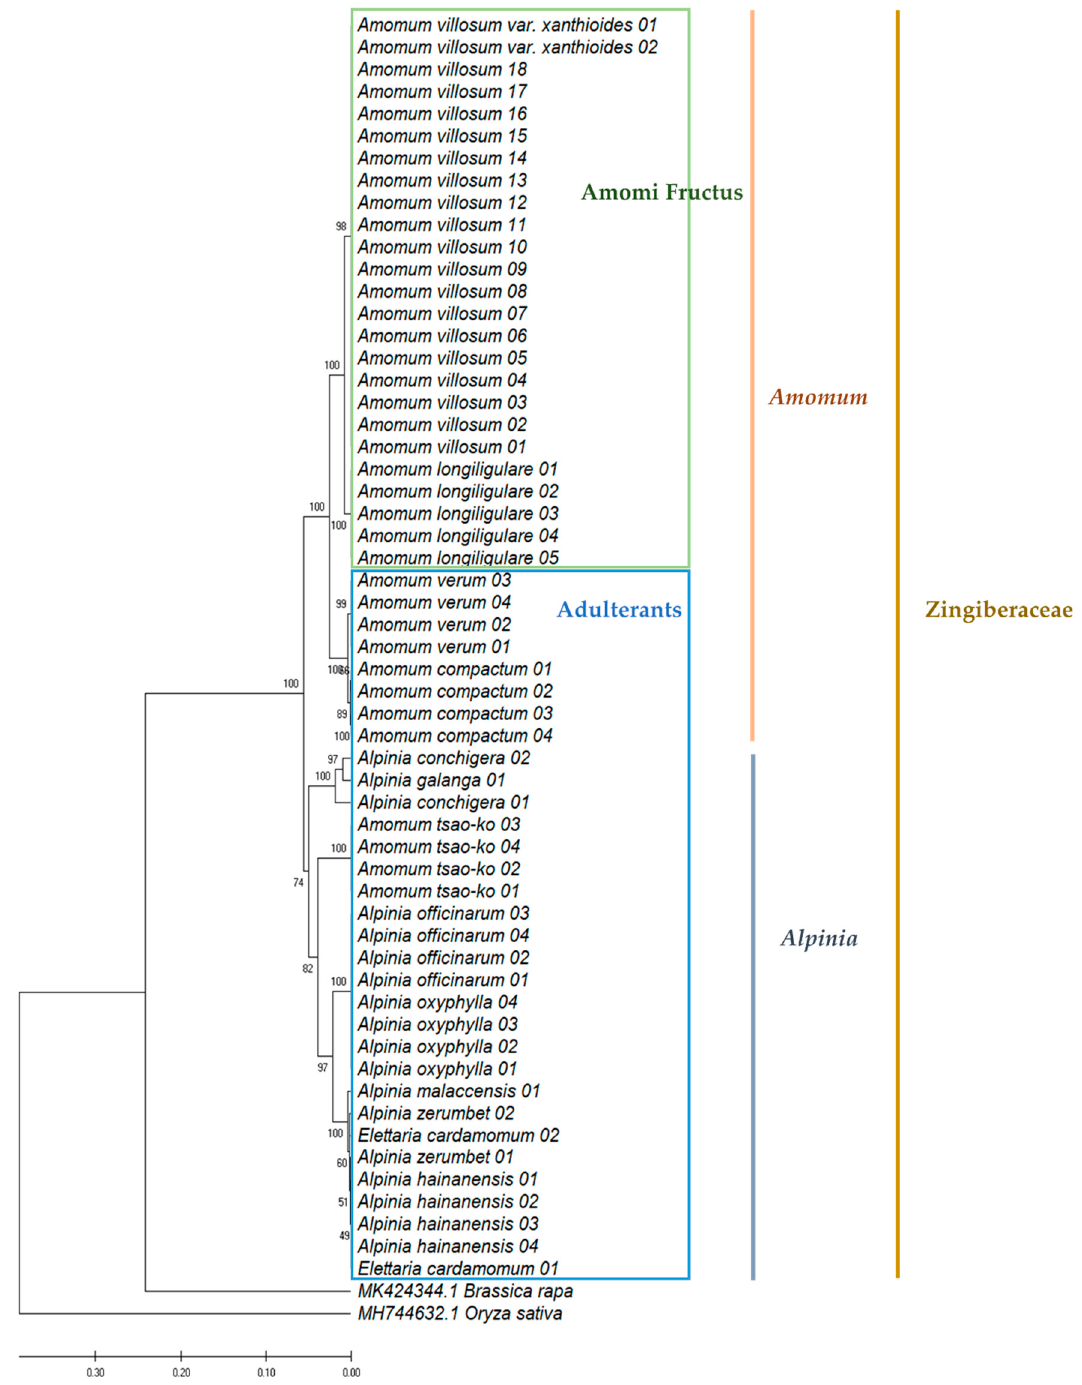
Figure 2. Phylogenetic analysis of Amomi Fructus and its adulterants based on the nucleotide sequences of internal transcribed spacer (ITS), including 5.8S rDNA region using the UPGMA method. The percentage of replicate trees in which the associated taxa clustered together in the bootstrap test (500 replicates) are shown next to the branches. The evolutionary distances were computed using the Maximum Composite Likelihood method and are in the units of the number of base substitutions per site. As outgroups, ITS nucleotide sequences of Brassica rapa (MK424344.1) and Oryza sativa (MH744632.1) were used.